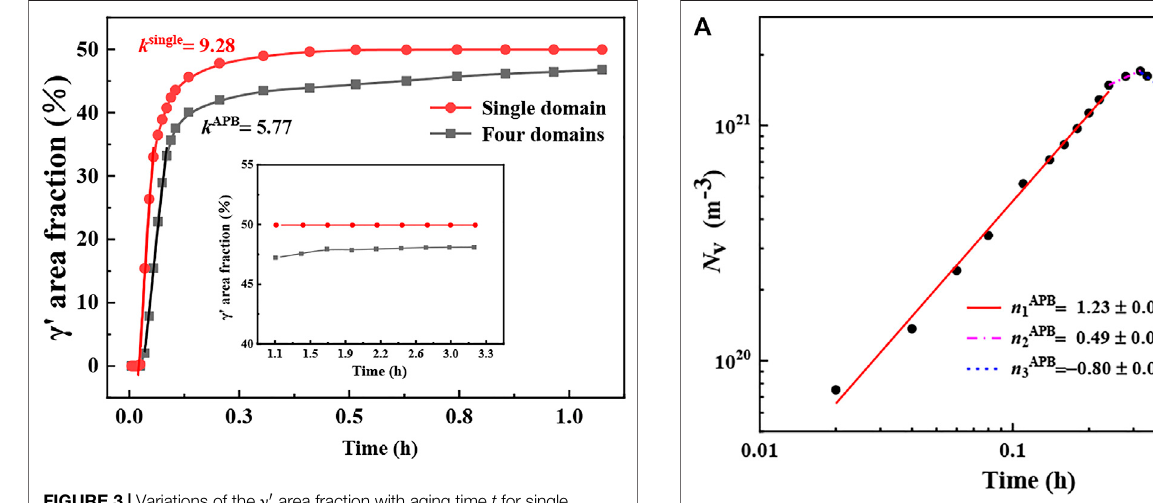
FIGURE 3 | Variations of the γ ′ area fraction with aging time t for single domain and four domains.